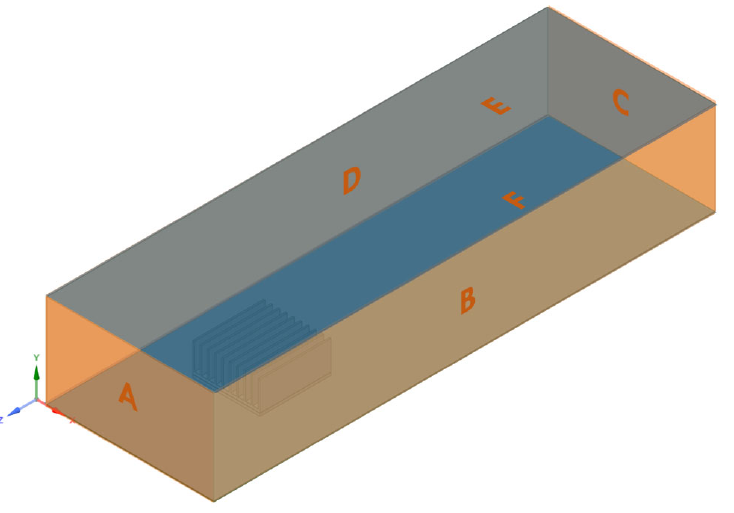
Figure 7. Nomenclature of external planes of the